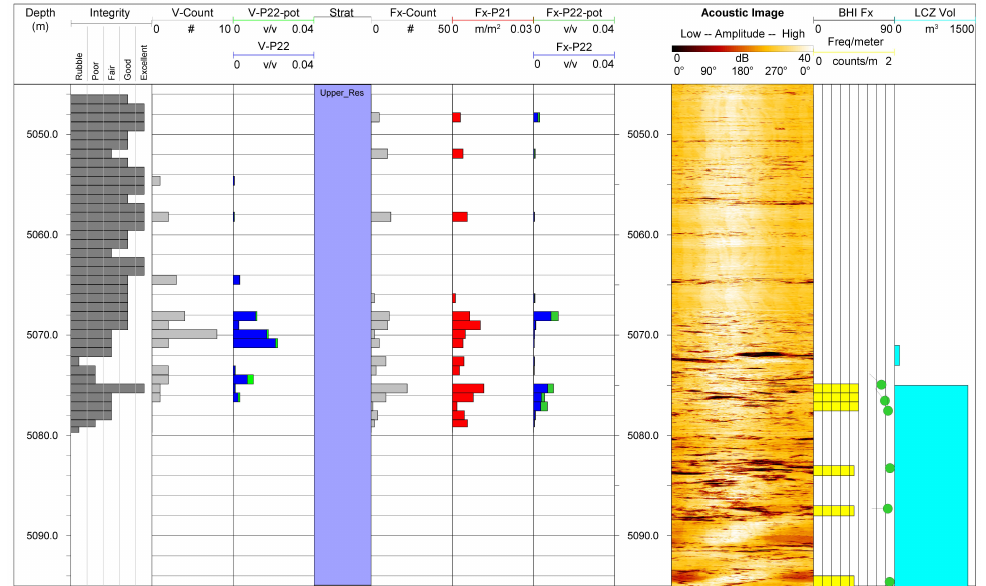
Figure 7. Single well showing the vertical distribution of non-matrix observations using the NMQP methodology compared with additional data, including borehole acoustic image log, fracture inter- pretation from image, and lost circulation zone (LCZ). From left to right: depth, core integrity, vug count, vug porosity (V-P22) and vug potential porosity (V-P22pot), stratigraphic unit, fracture count (Fx-count), fracture density (Fx-P21), fracture porosity (Fx-P22) and fracture potential porosity (Fx- P22pot), acoustic image log (amplitude), tad poles to image log fracture interpretation and fracture frequency, and top and base of lost circulation zone with volume lost (LCZ). In the vug and fracture potential porosity tracks, the blue fill represents the actual open porosity, and the green represents the proportion of space filled by cements.